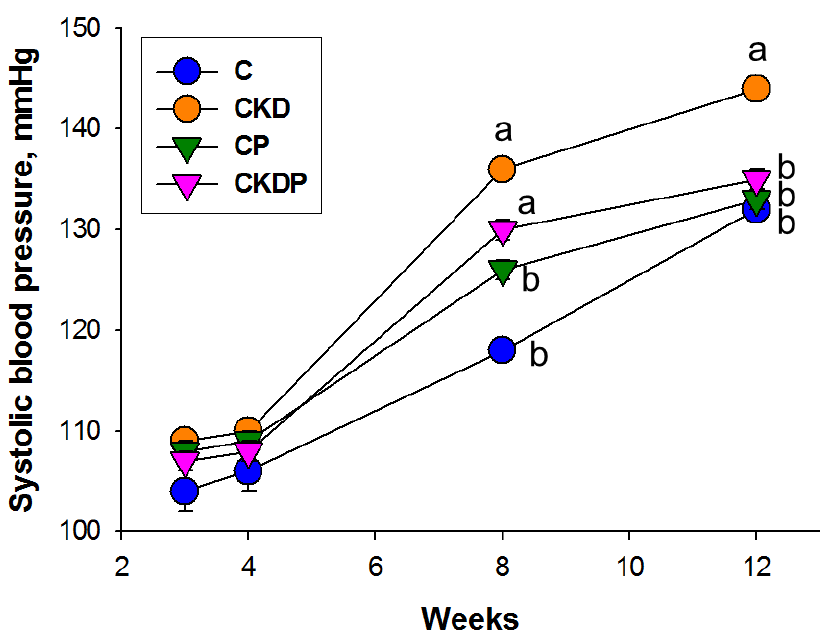
Figure 2. Effect of maternal CKD and propionate (P) supplementation on systolic blood pressure in offspring from 3 to 12 weeks of age. The letters a and b show significant differences between groups ( p < 0.05, two-way ANOVA); N = 7 – 8/group. C = control; CKD = adenine-treated rats; CP = control rats received propionate; CKDP = adenine-treated rats received propionate.